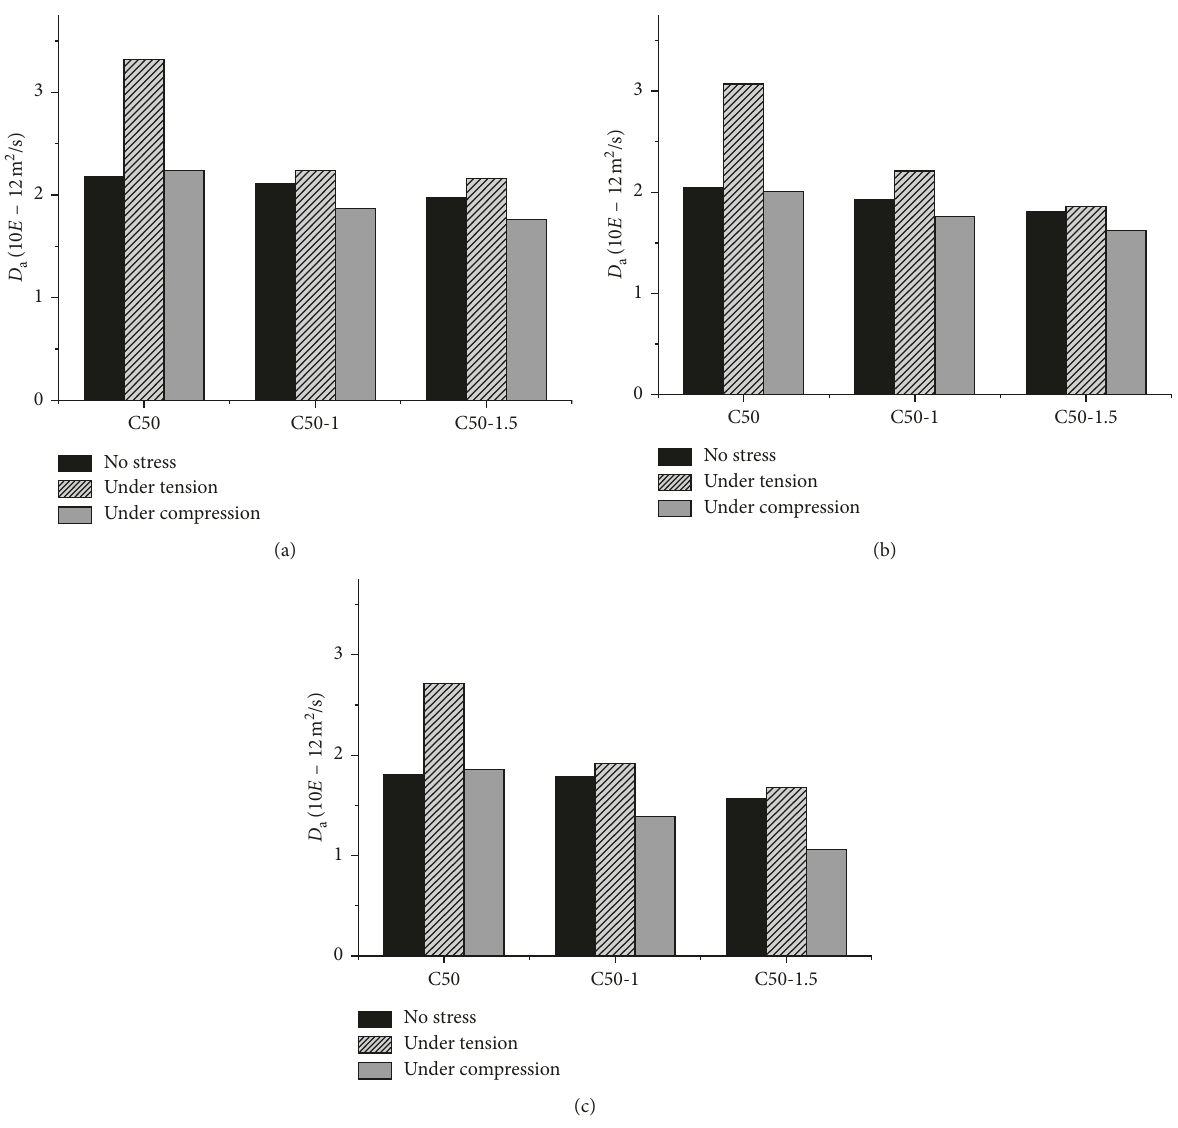
Figure 2: Results of best-fit apparent chloride diffusion coefficients. Immersion time: (a) 60d, (b) 90d, and (c)